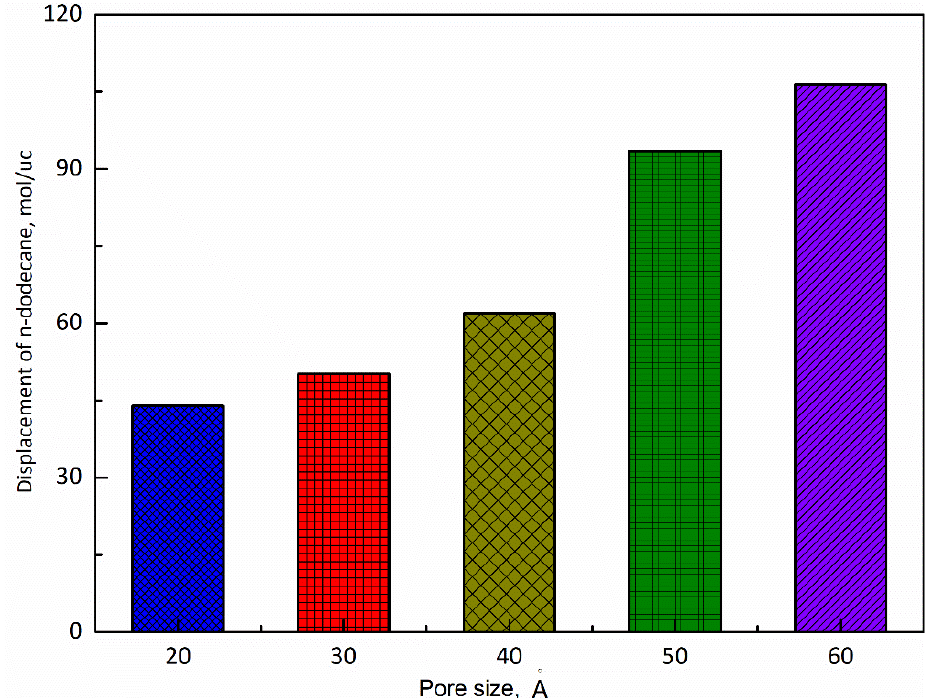
Figure 7. The molar quantity of n-dodecane displaced by CO 2 in the pores of different sizes under CO 2 injection pressure of 60 MPa .